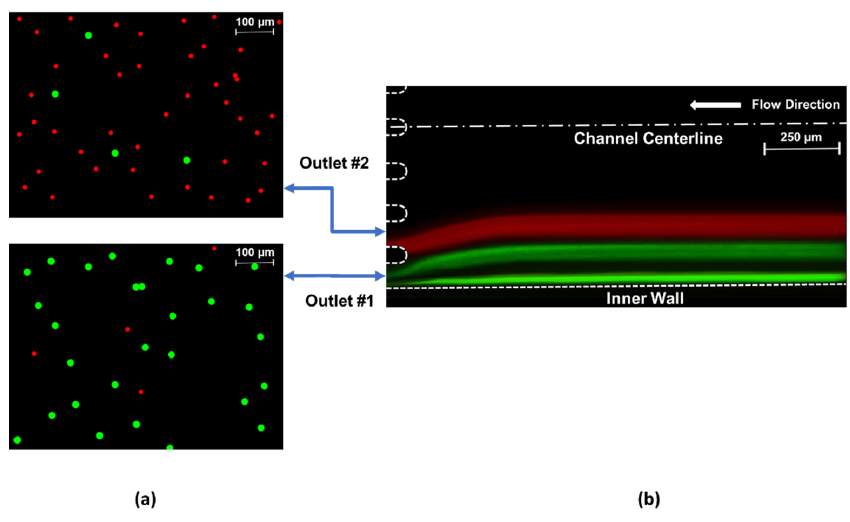
Figure 7. ( a ) The fluorescent microscopic views of samples utilized for particle counting and ( b ) the superimposed fluorescent image of two focused streamlines: red (10 µm) and green (20 µm) illustrating particle migration for Case 4 at the optimum flow conditions (approximately Re c 195).